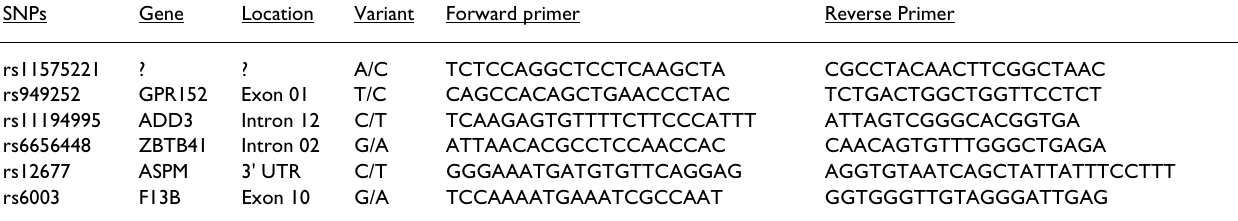
Table 5: PCR Conditions